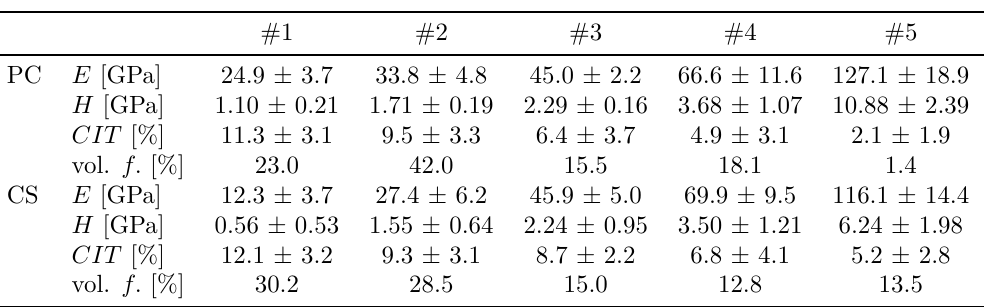
Table 2. Mean values and standard deviation of individual deconvoluted phases of modulus of elasticity, hardness, CIT and volume fraction.